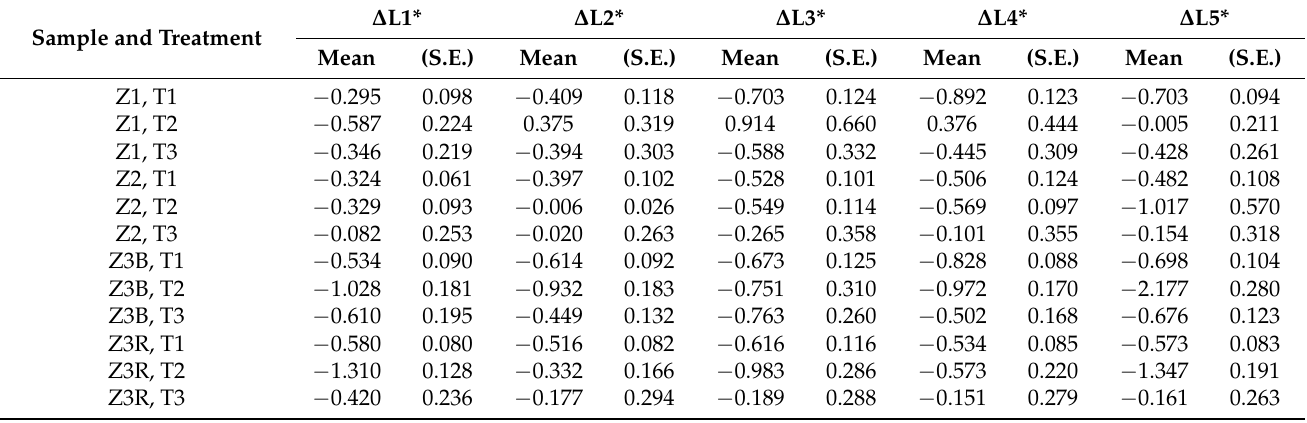
Table 3. Average values for ∆ L* for every ageing treatment cycles. Sample and